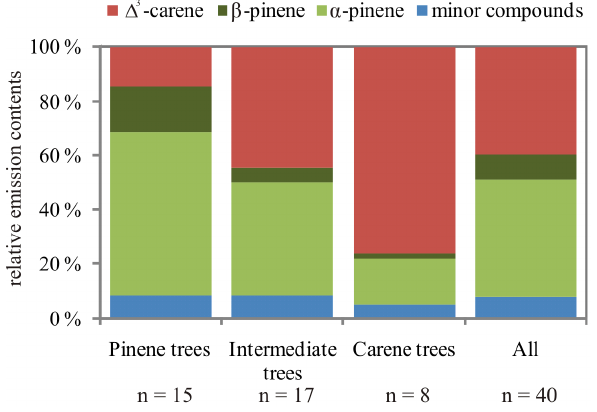
Fig. 3. Average relative emission contents of three clusters. Clus- Figure 4. 839 tering conducted with the major emitted compounds. 838